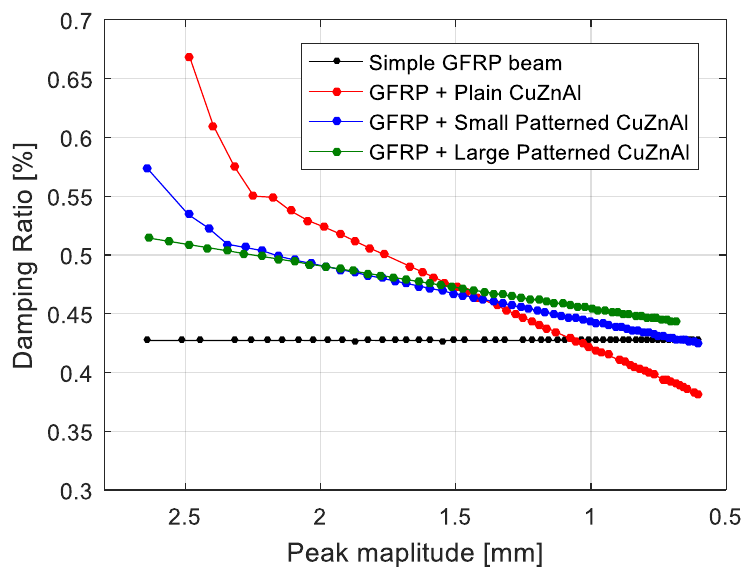
Figure 11. Comparison of the damping ratio as function of displacement for each architecture of Cu 66 Zn 24 Al 10 hybrid